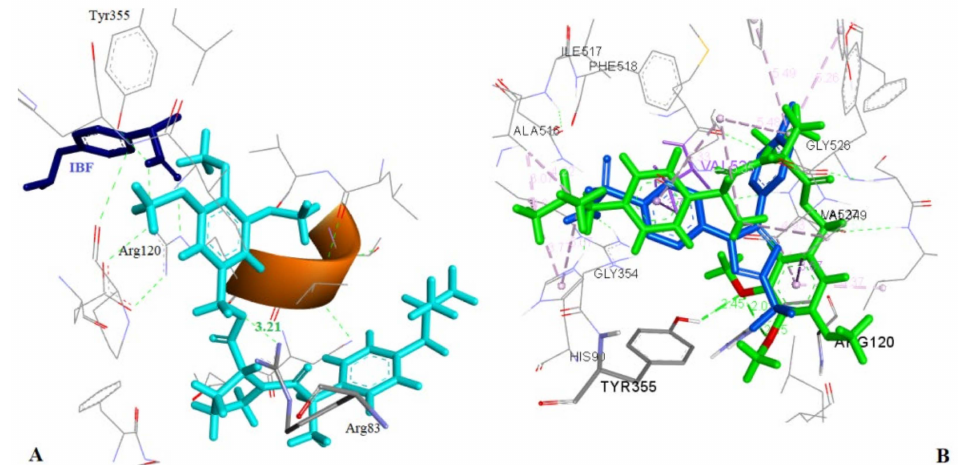
Figure 3. ( A ). Docked compound 19 (cyan) superimposed on the co-crystallized ibuprofen (blue) in the binding pocket of COX-1. ( B ) Docked compound 19 (green) superimposed on the co-crystallized SC-558 (blue) in the binding pocket of COX-2.